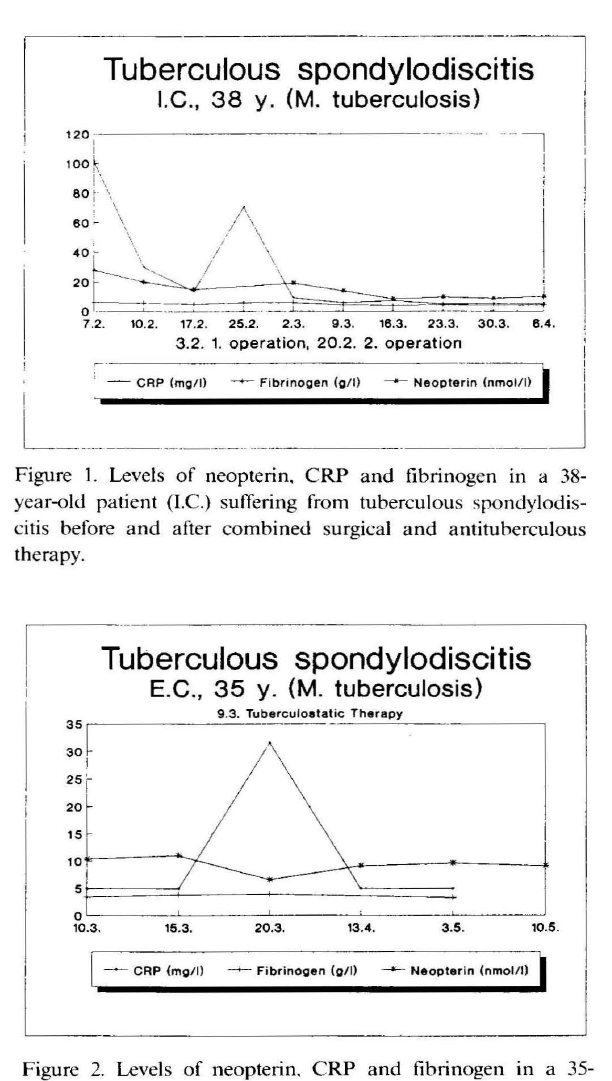
Table I. Neopterin and the "classic" inflammation markers CRP. fibrinogen. ESR and WBC in 6 patients with proven tuberculous bone infections before starting an antituberculous therapy. Inflammation markers in patients with tuberculous bone infections